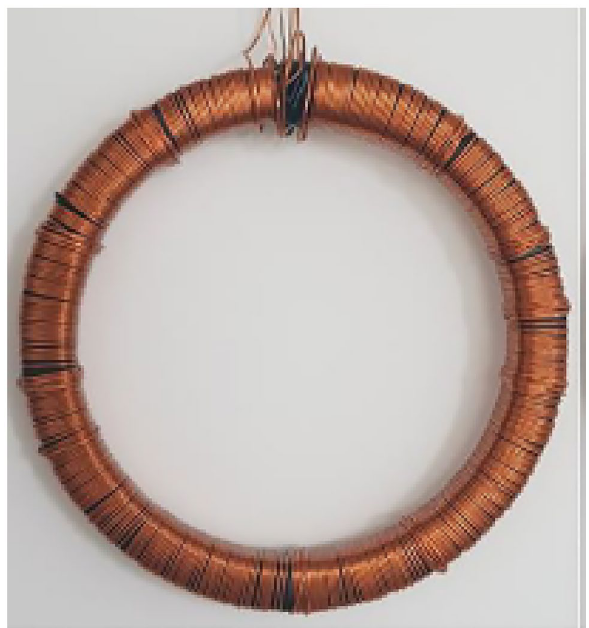
Figure 14. Reference magnetic circuit.